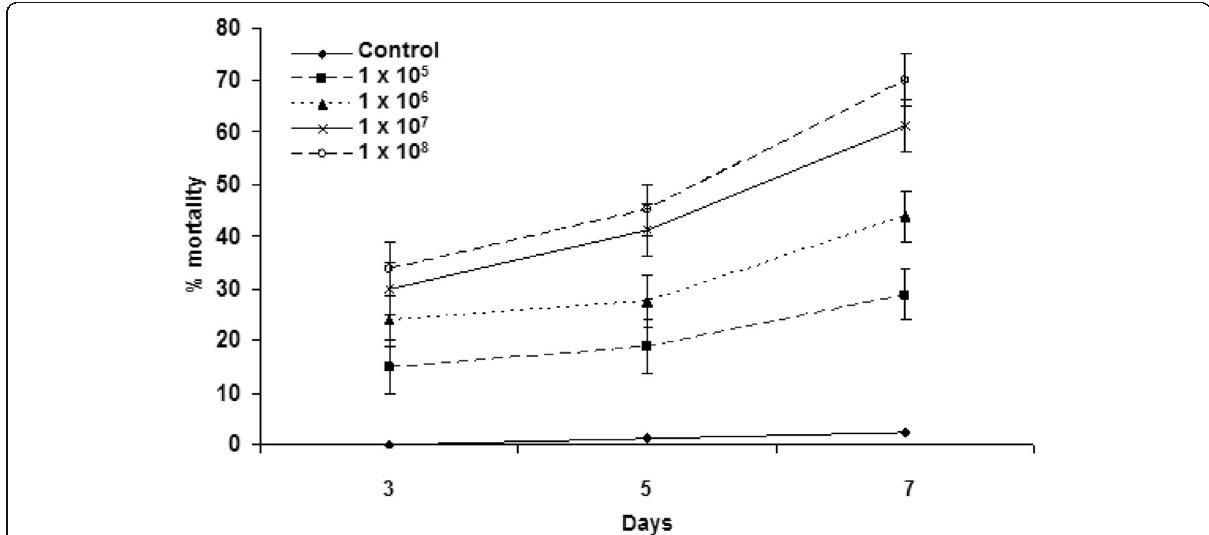
Fig. 2 Lethal effect of Beauveria bassiana isolate to Tetranychus urticae after treatment with conidial suspensions at concentration 1 × 10 5 , 1 × 10 6 , 1 × 10 7 , 1 × 10 8 conidia ml − 1 (control variant, 0 conidia) Error bars: